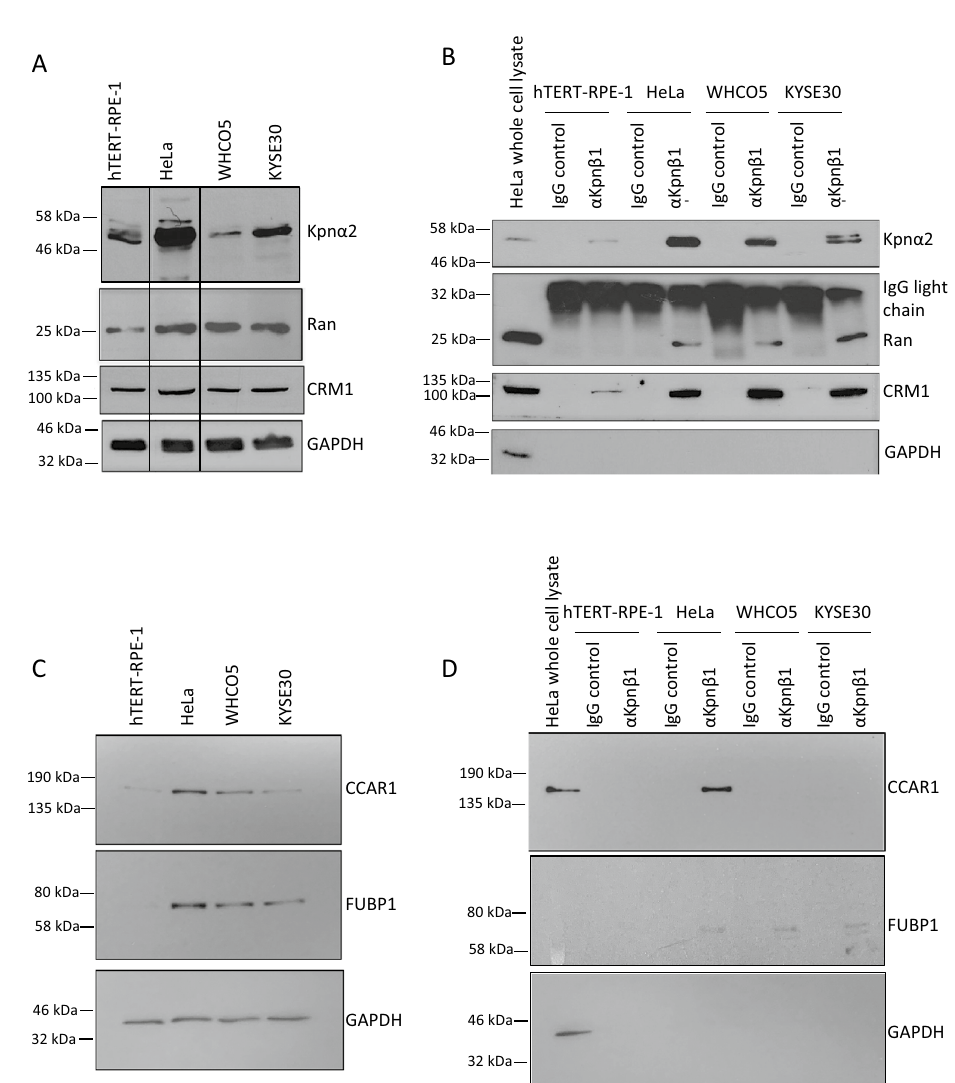
Figure 5. Validation of Kpnβ1 binding partners identified by IP-MS. ( A ) Expression of known Kpnβ1 interactors, Kpnα2 and Ran, and CRM1, was analysed in hTERT-RPE-1, HeLa, WHCO5 and KYSE30 whole cell lysates (30 µg) by Western blot analysis. GAPDH was used to control for protein loading. ( B ) Co-immunoprecipitation assays were performed and Kpnα2, Ran and CRM1 proteins detected by Western blot analysis. GAPDH was used as a negative control, as it is not expected to bind Kpnβ1. CRM1, Kpnα2 and Ran proteins were not pulled down in lysates incubated with a non-specific IgG isotope control and protein A agarose beads. 10 µg HeLa protein lysate was included as a positive control. ( C ) Western blot analysis showing expression of novel Kpnβ1 interactors, CCAR1 and FUBP1 in hTERT-RPE-1, HeLa, WHCO5 and KYSE30 whole cell lysates. GAPDH was used to control for protein loading. ( D ) Co-immunoprecipitation assays showing successful pull-down of CCAR1 and FUBP1 with Kpnβ1. GAPDH was used as a negative control. CCAR1 and FUBP1 were not pulled down in lysates incubated with a non-specific IgG isotope control and protein A agarose beads. Experiments were performed two